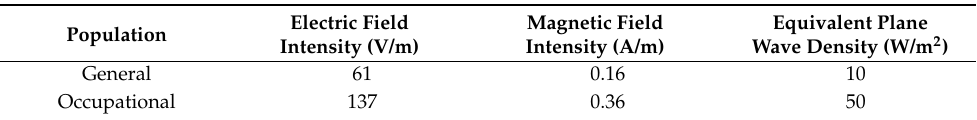
Table 1. Population exposure limits to Radio Frequency—Electromagnetic Fields (RF-EMF) for the 2 GHz to 300 GHz